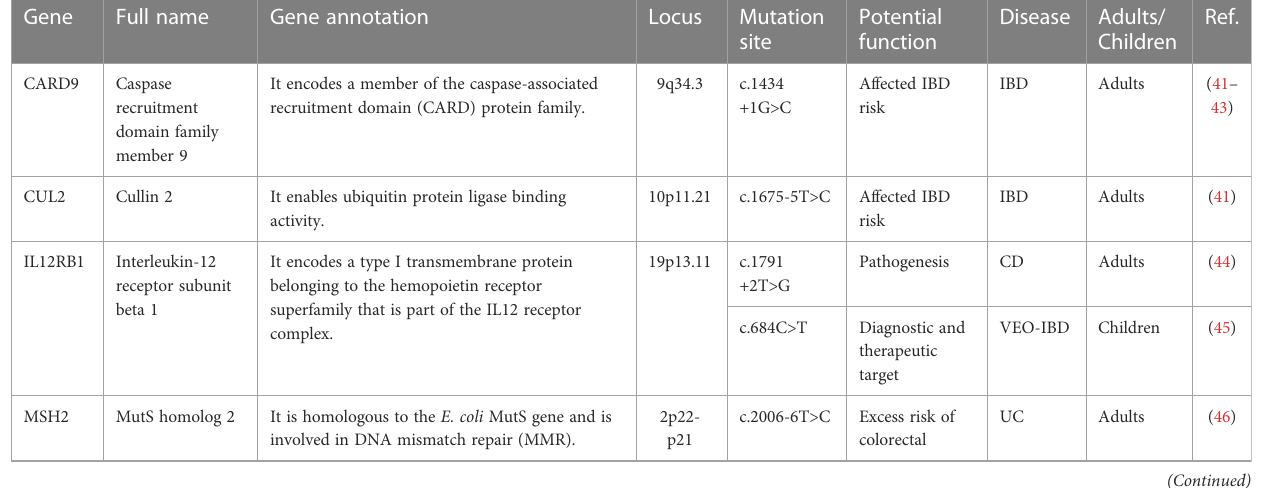
TABLE 3 Mutations of splice or associated with splicing have been reported in IBD of children and